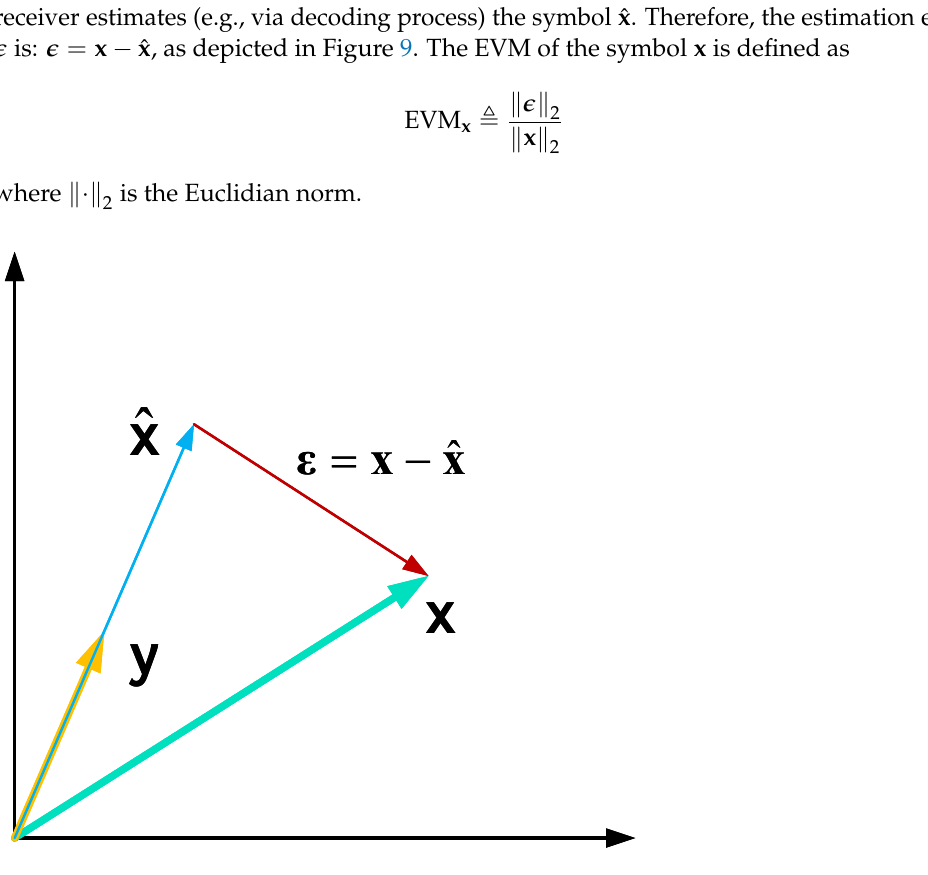
Figure 9. The illustration of EVM principle. The blue arrow denotes the transmitted symbol, the yellow arrow denotes the received symbol, the blue arrow denotes the estimate, and the crimson arrow denotes the estimation